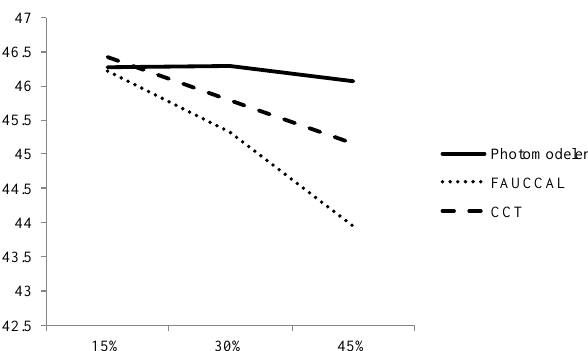
Figure 5. The computed camera constant according to the water percentages.